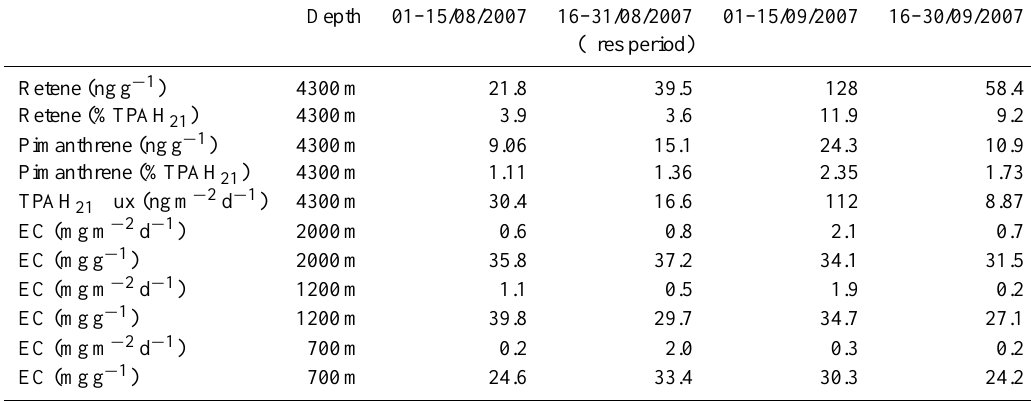
Table 4. Retene, pimanthrene (ngg − 1 and %TPAH 21 ) and TPAH 21 flux for 4300m depth and EC fluxes (mgm − 2 d − 1 ) and concentrations (mgg − 1 ) for the traps deployed at 700, 1200 and 2000m depth during and after the Peloponnese fires in August 2007.